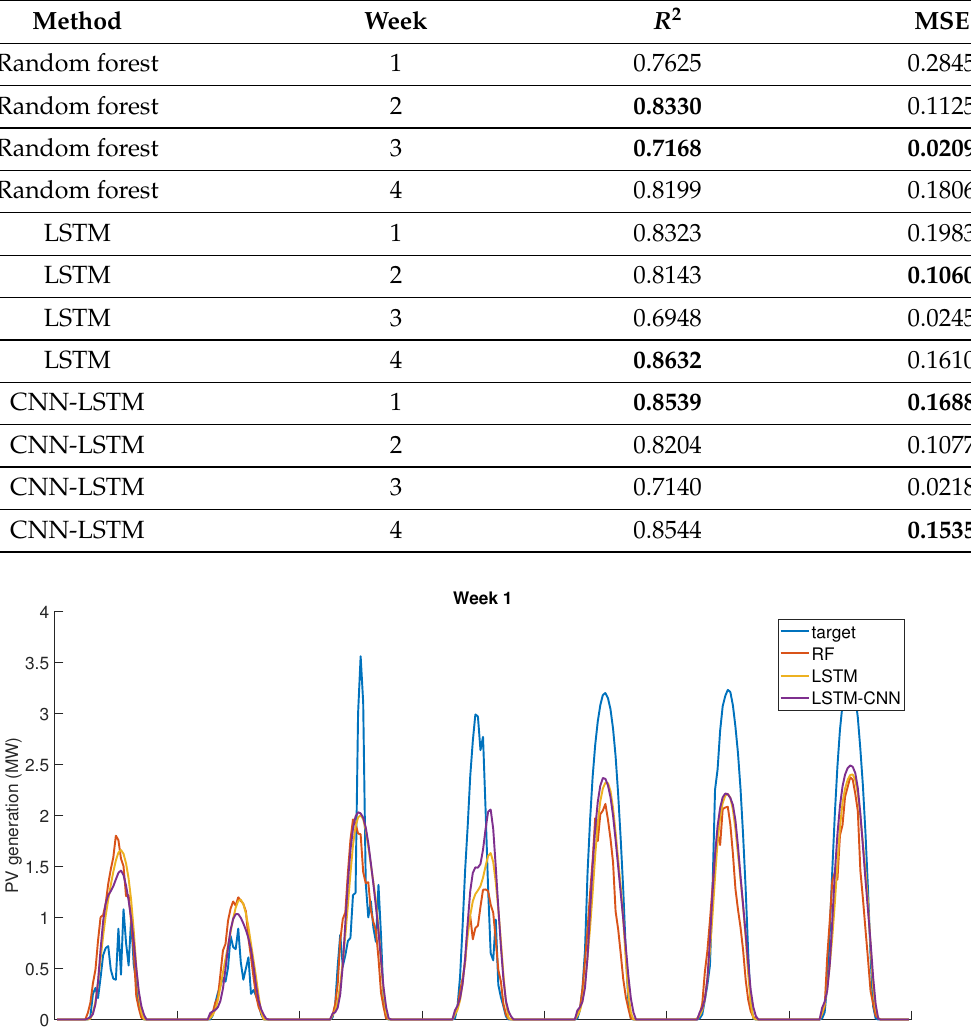
Table 2. Comparison of three methods in predicting the PV power for the challenge weeks. The high- est R 2 and lowest MSE for each week are highlighted in bold.